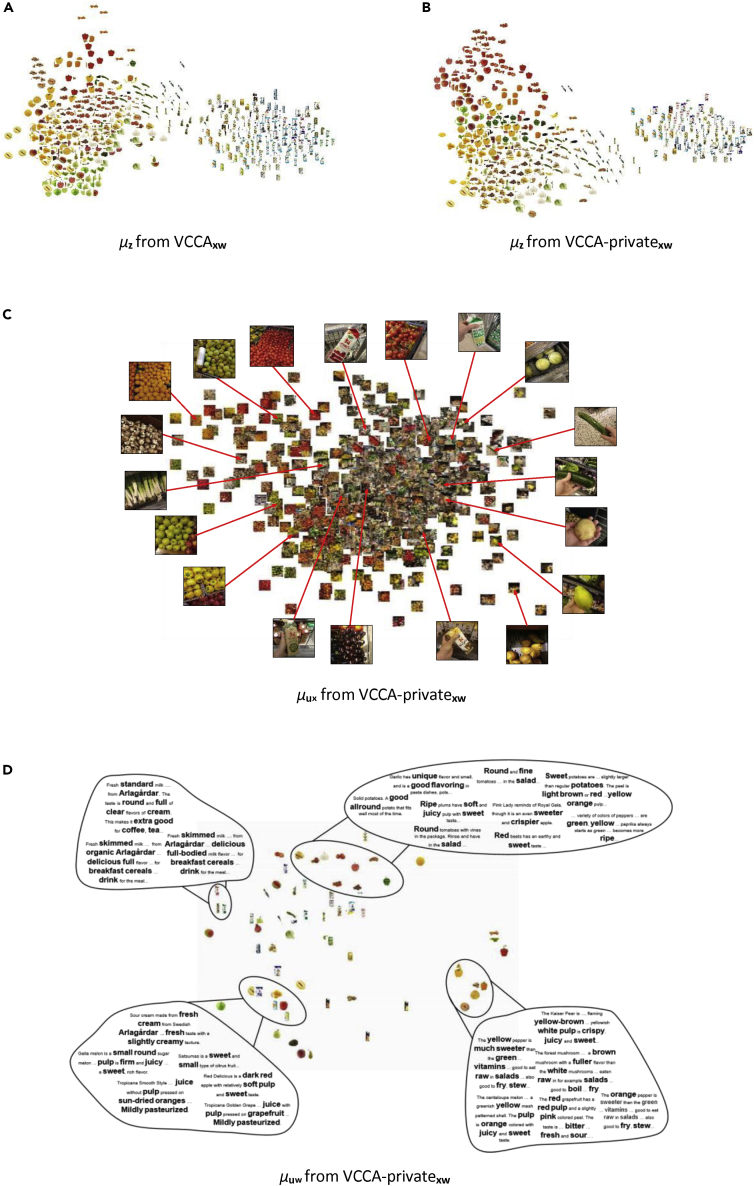
Visualizations of the Latent Representations μz from VCCAxw and VCCA-privatexw Followed by μuw and μux for VCCA-privatexwRepresentations from Variation Canonical Correlation Analysis (VCCA)xw (A) and VCCA- privatexw (B), followed by μuw and μux for VCCA-privatexw (C).